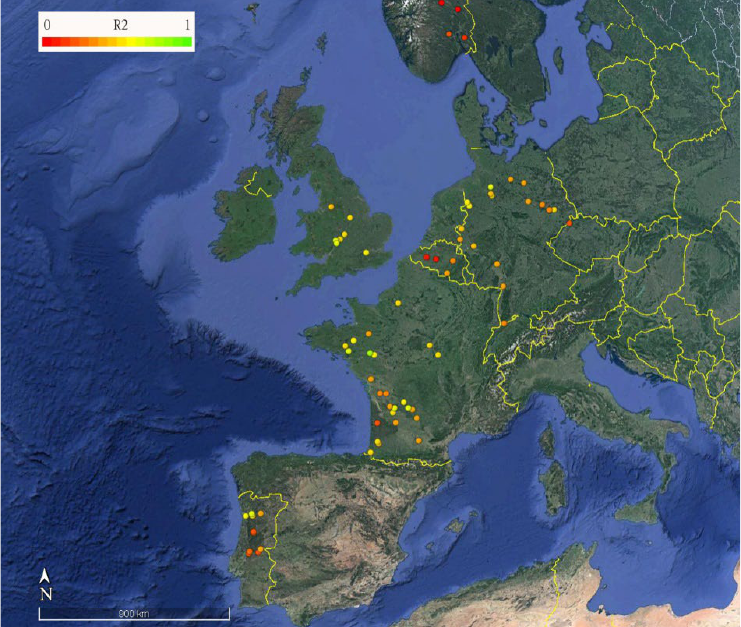
Figure 4. Coefficient of determination (R 2 ) between observed and modelled river flow for the stations with available data for the period 2008–2019.